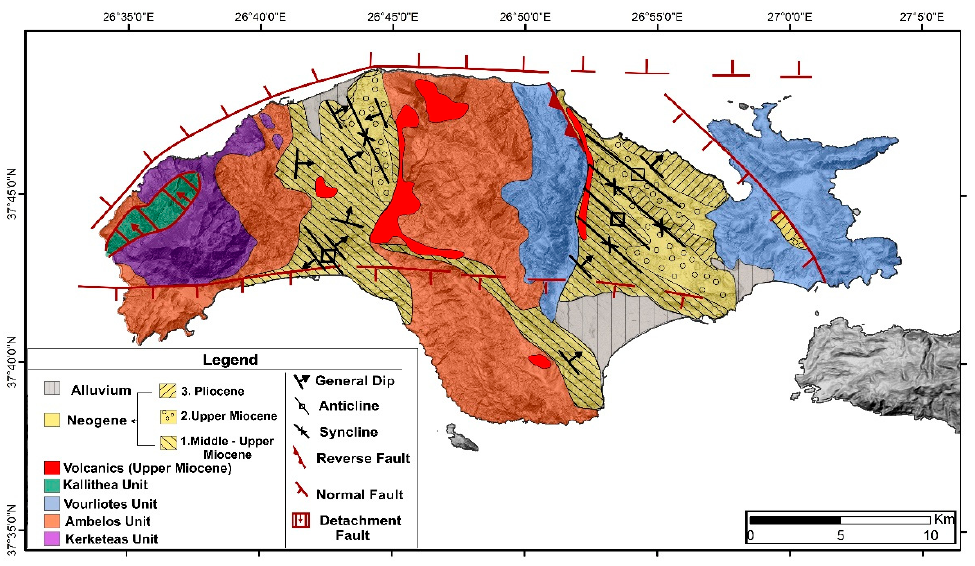
Figure 2. Simplified geological map of Samos Island [22,23].